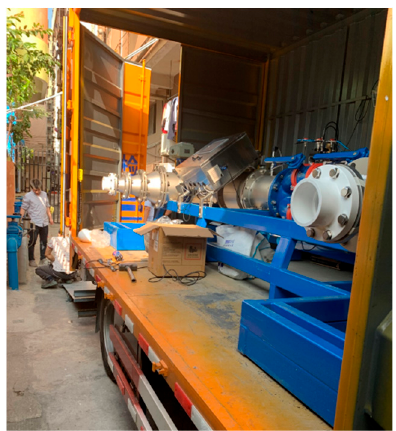
Figure 5. The IPRV at the pilot site.